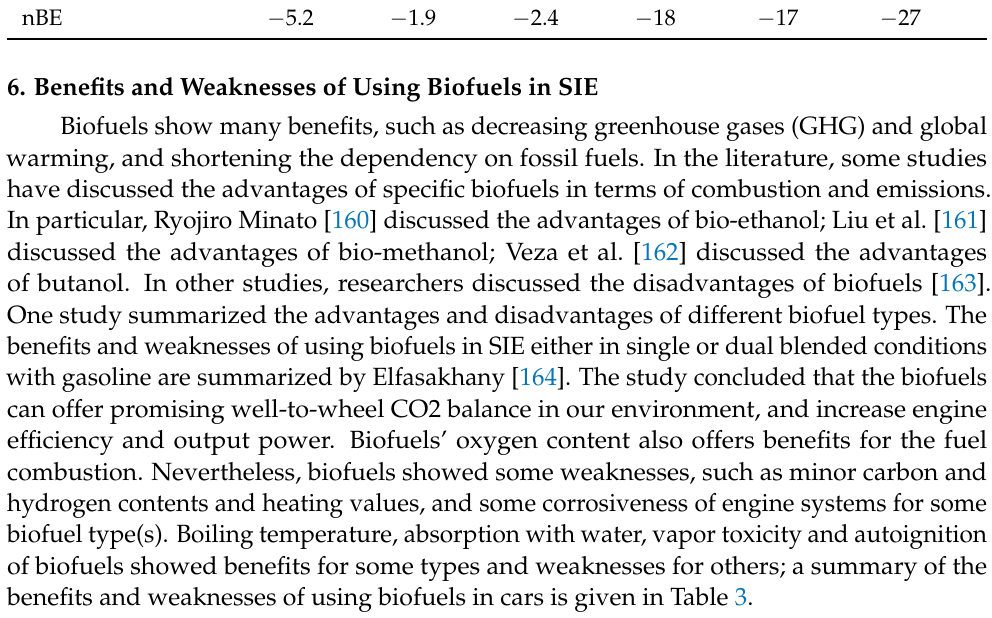
Table 3. Benefits and weaknesses of using biofuels compared to gasoline in SI engines. Properties